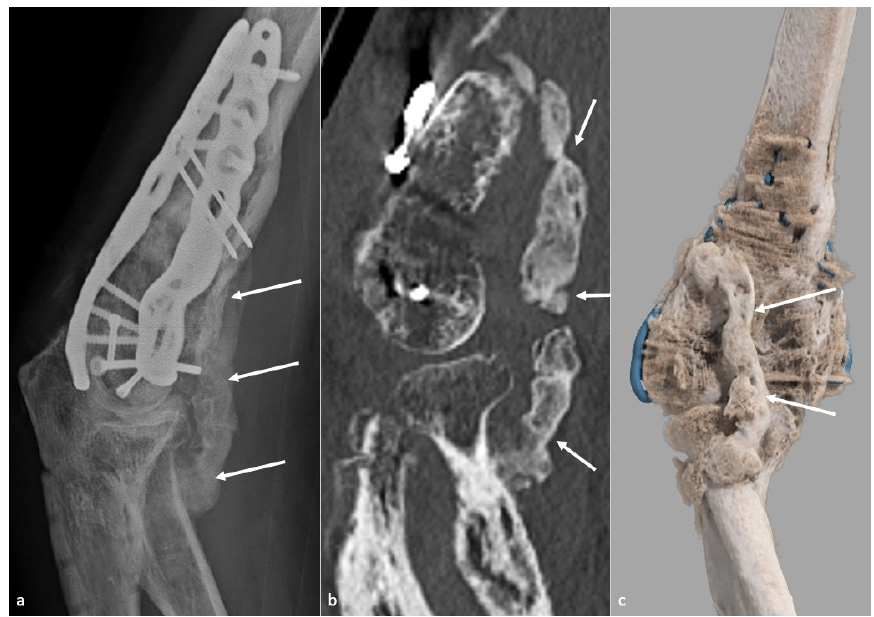
Figure 1. Heterotopic ossification forming a bony bridge between the humerus and the radial neck . Heterotopic ossification (white arrow), leading to severe loss of flexion in a 54-year-old man who suffered from a complex fracture–dislocation, shown ( a ) on a profile view radiograph, ( b ) a sagittal CT-scan reformat, and ( c ) a global illumination 3D reformat.